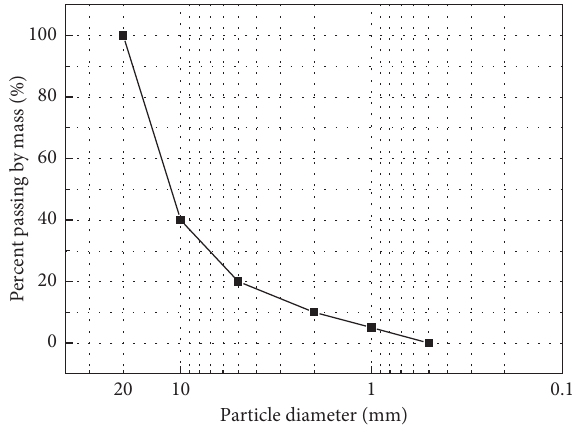
Figure 2: Stone particle size